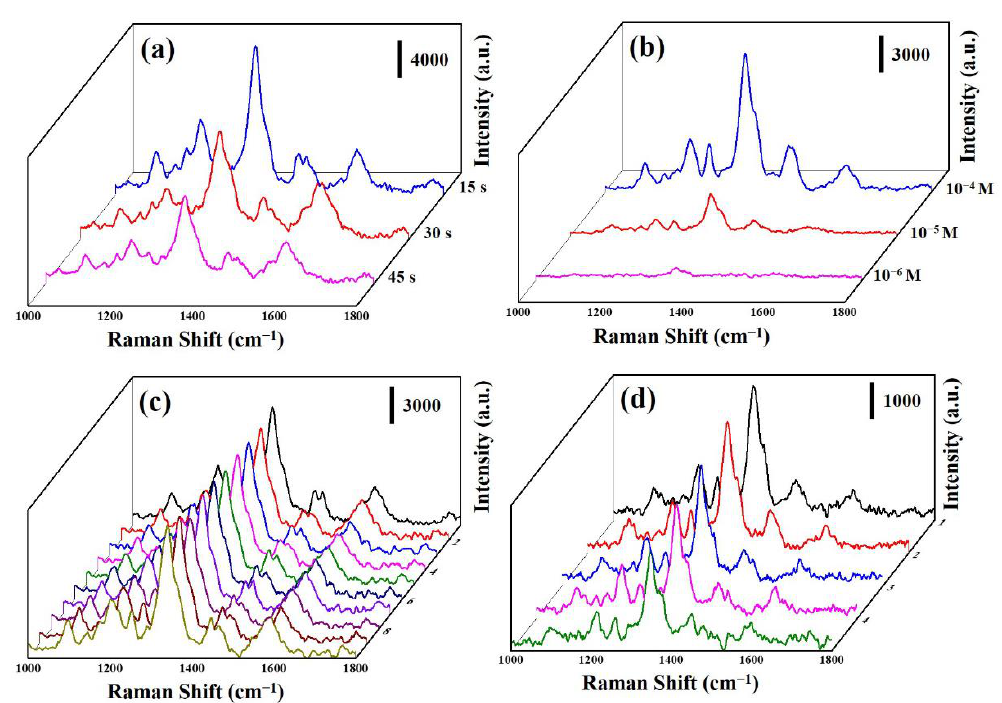
Figure 8. ( a ) Photocatalytic activities of Er-doped ZnO/CuS/Au core-shell nanowires with various scavengers under blue LED light. ( b ) Schematic diagram of the electron transfer mechanism of Er-doped ZnO/CuS/Au core-shell nanowires un- der blue LED light.